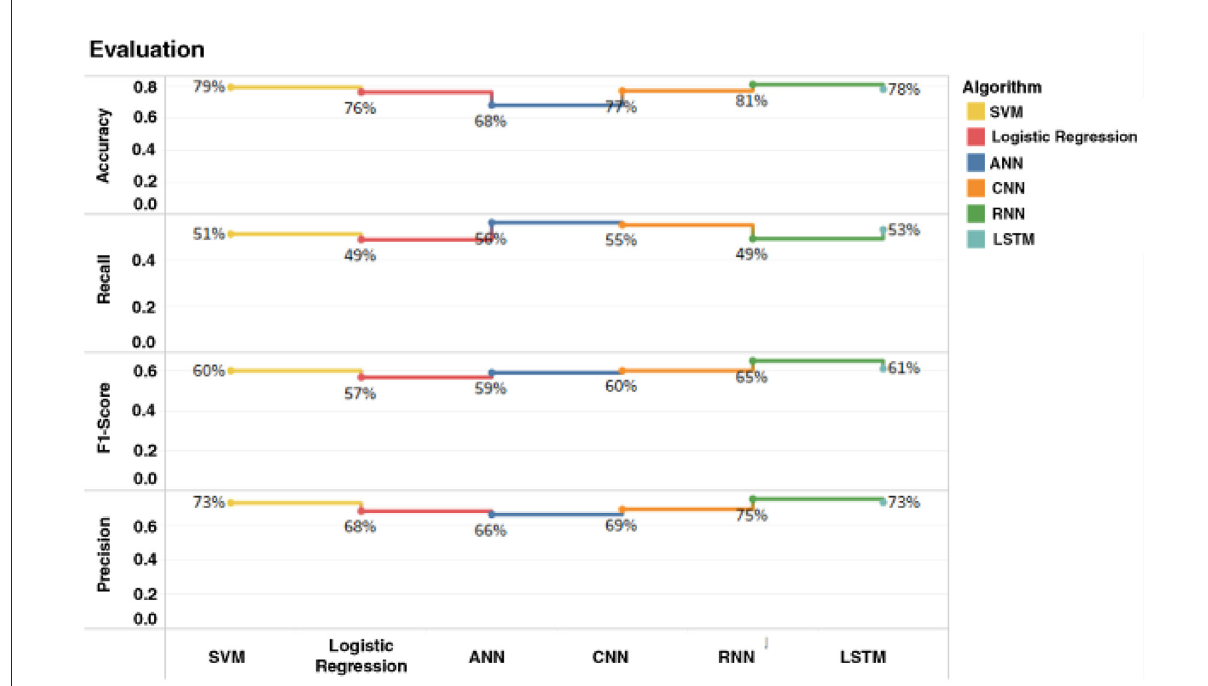
FIGURE6 Comparable graphical view of accuracy, precision, recall, and F1-Score for the classification approaches i.e., SVM, Logistic regression, ANN, CNN, RNN, and LSTM.